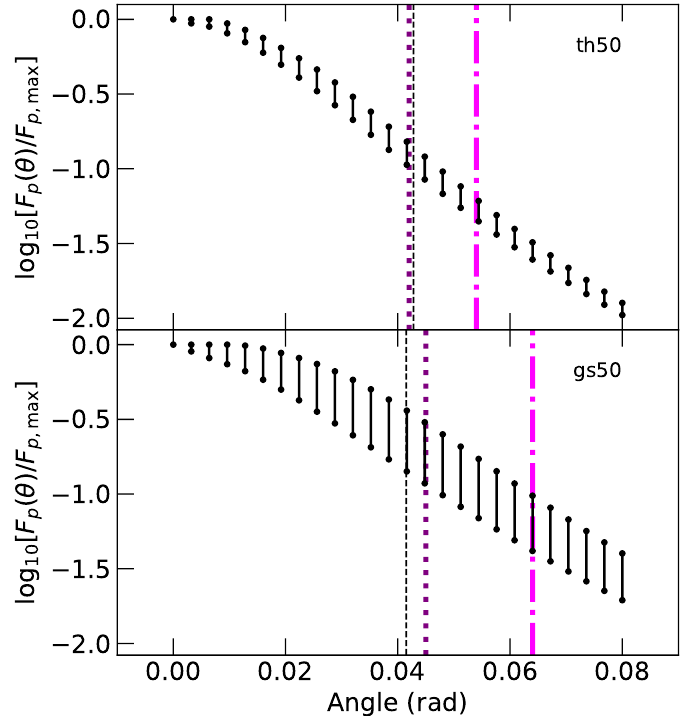
Figure 3. The range in afterglow peak flux values relative to the maximum afterglow peak flux through rotation in φ of the jet at a fixed polar angle, equivalent to the line-of-sight inclination, within the γ -ray bright jet region for each structure profile. The purple dotted vertical line indicates the inferred jet opening angle for an on-axis observer, given the jet break time; the black dashed line indicates the jet core angle from mean jet profile fits; and the pink dash-dotted line indicates the maximum angle at which the jet is optically thin to γ